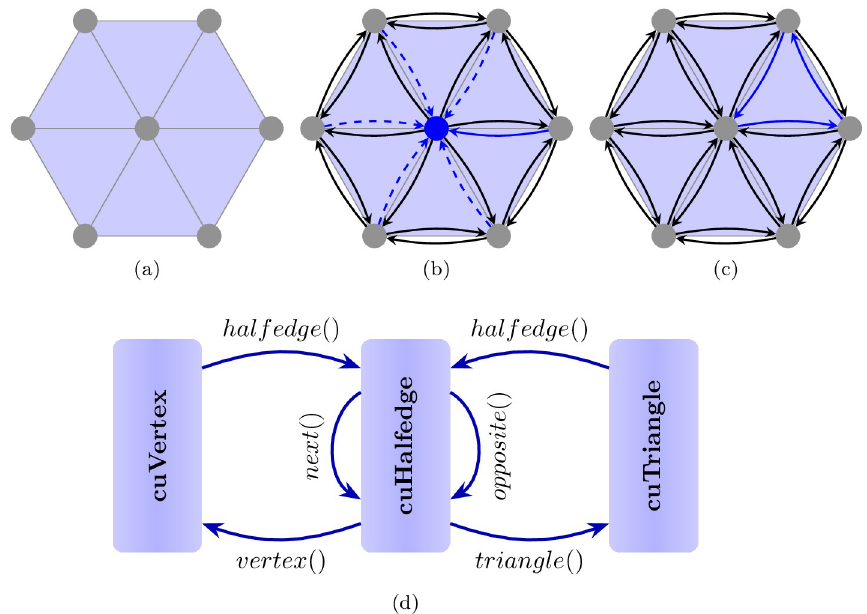
Fig 2. The halfedge data structure. (a) A triangular mesh, (b) the vertex is identified by one of its incident halfedges, (c) the triangle is identified by its three incident halfedges, and (d) the design of the data structure reflecting the relationship between the three